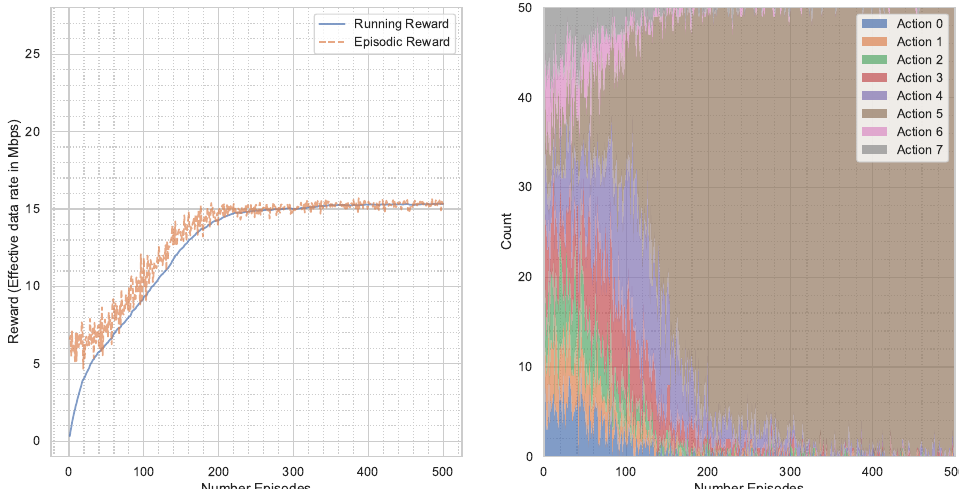
Figure 4. The behavior of the NAC reinforcement learning approach on an AWGN channel at a static SNR level of